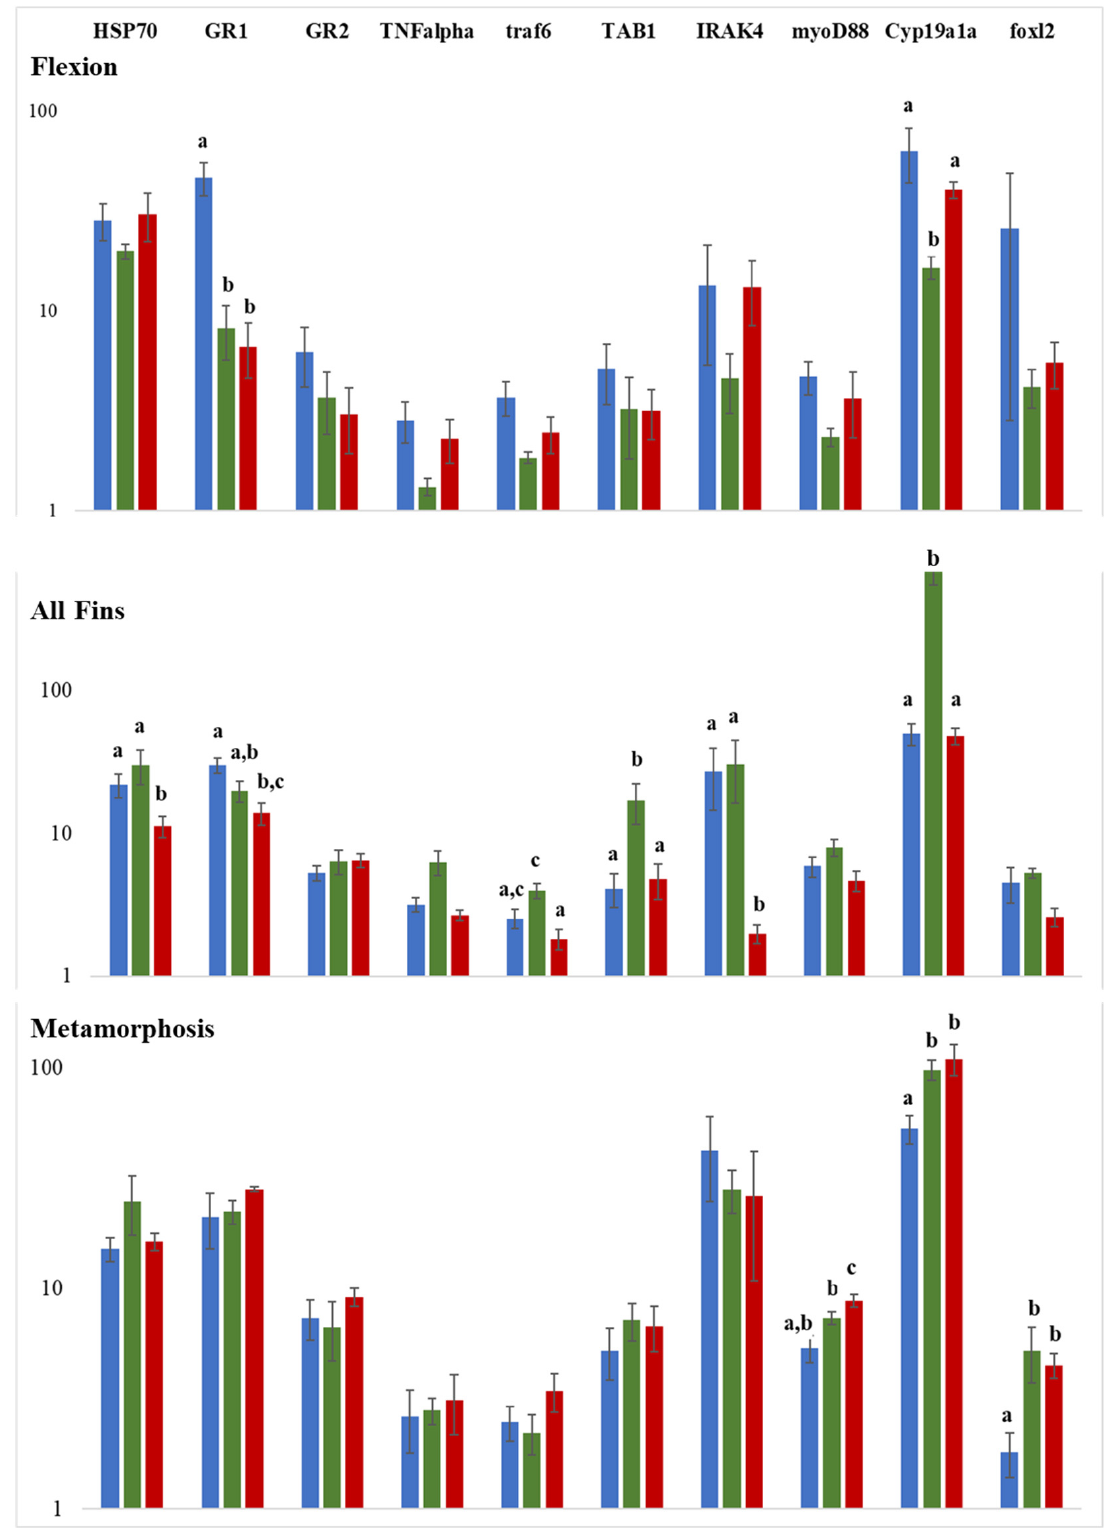
Figure 8. Gene expression analysis by qPCR of ten genes involved in reproduction and stress/immune response. Y-axes represent the relative gene expression on a log scale and x-axes the genes under study. Significance is indicated by different letter codes. Colors represent the mode of comparison, i.e. , blue 15 °C versus 17.5 °C, red 15 °C versus 20 °C, and green 17.5 °C versus 20 °C. The number of individuals tested was n = 4. Different letters denote significant differences between experimental groups.